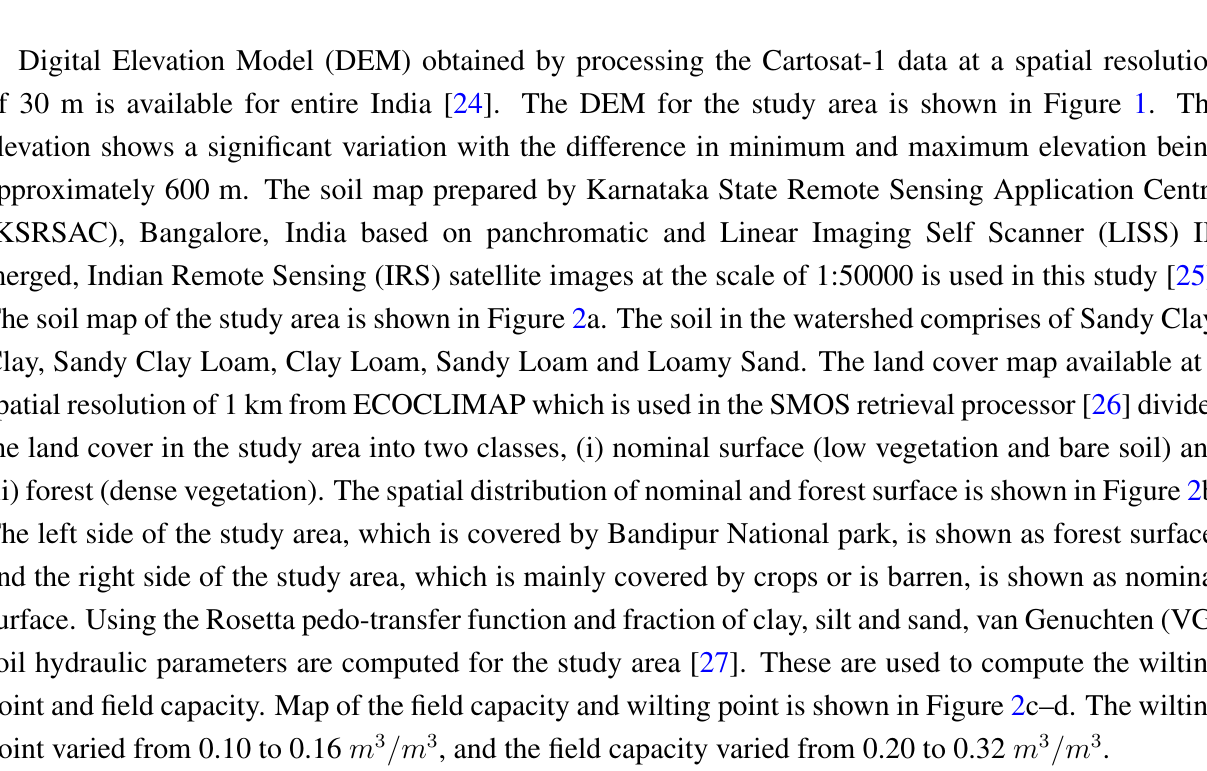
Figure 1. Location of the study area inside India (shown in inset) and Digital Elevation Model (DEM) of the study area along with the location of field plots and SMOS